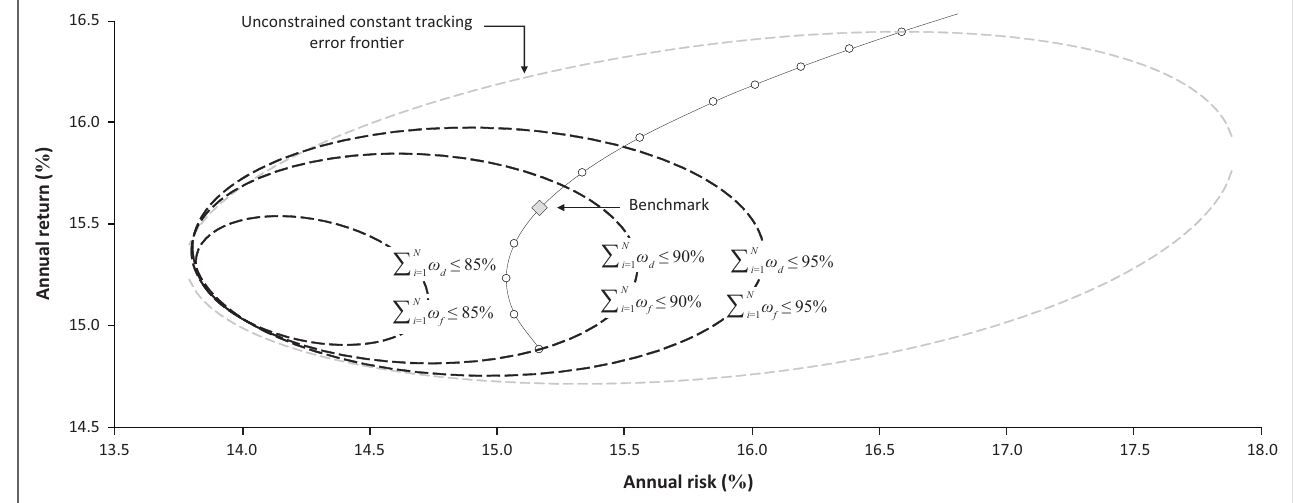
w ≤ 95 % and 90 % and sum of i di